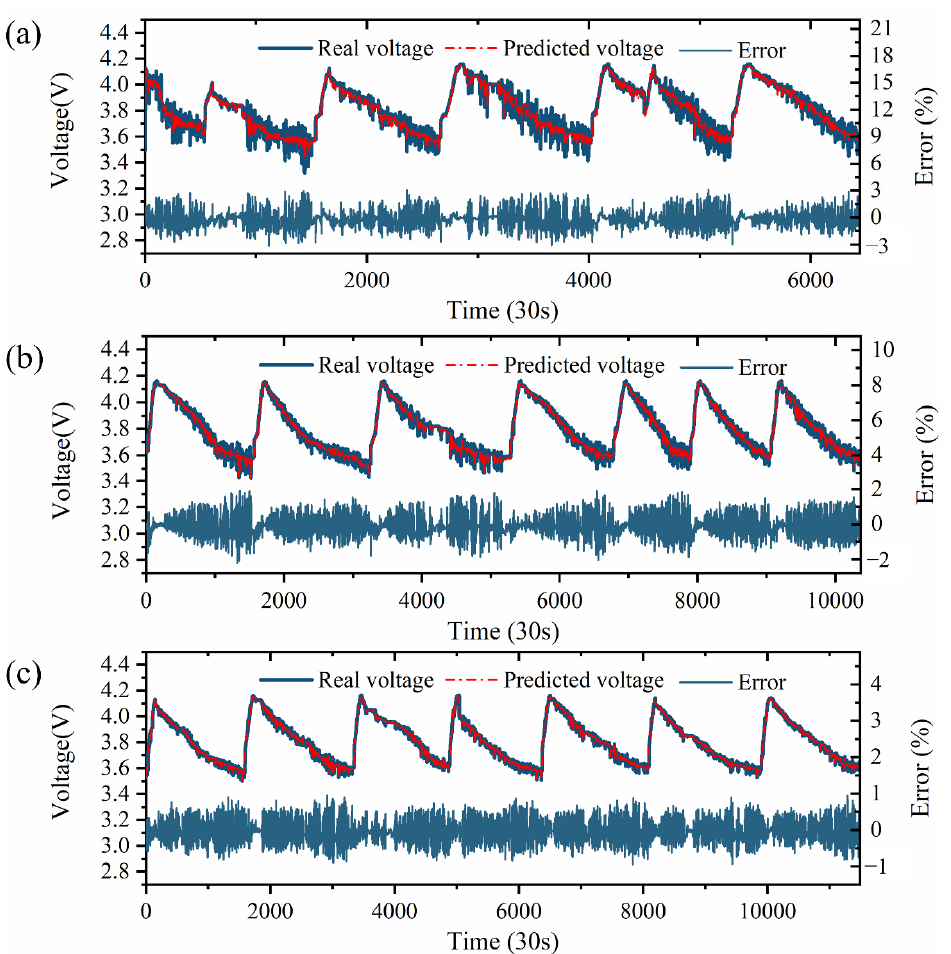
Figure 7. Voltage prediction results on different packs. ( a ) No.1 vehicle in the temperature range of − 5~10 °C. ( b ) No.2 vehicle in the temperature range of 10~20 °C. ( c ) No.3 vehicle in the temperature ◦ C. ( b ) No.2 vehicle in the temperature range of 10~20 ◦ C. ( c ) No.3 vehicle in the temperature range of 20~30 °C. − 5~10 range of 20~30 ◦